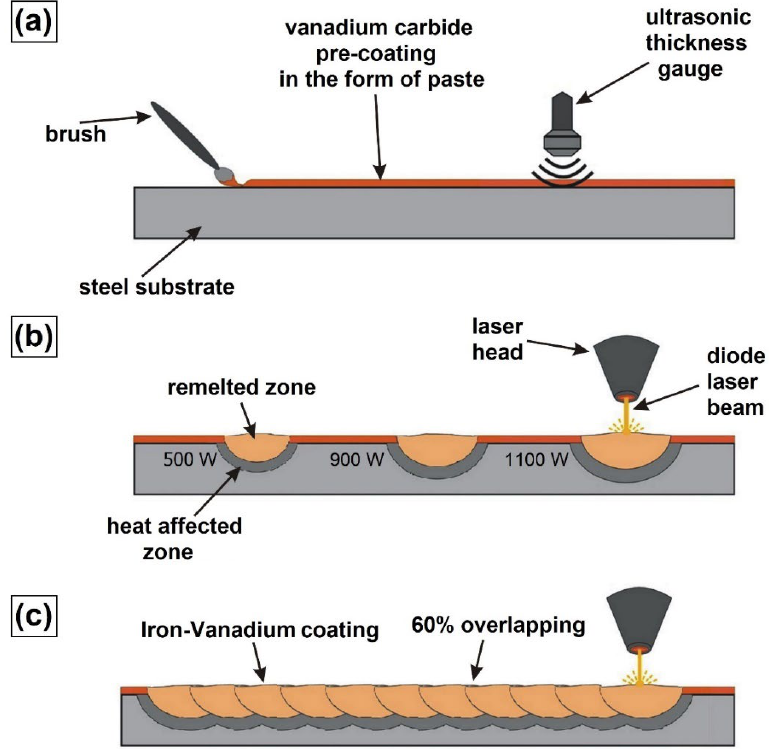
Figure 2. Scheme of Fe–V coating production using laser processing: ( a ) pre-coat application and thickness testing, ( b ) single laser tracks production, ( c ) multiple laser tracks production.